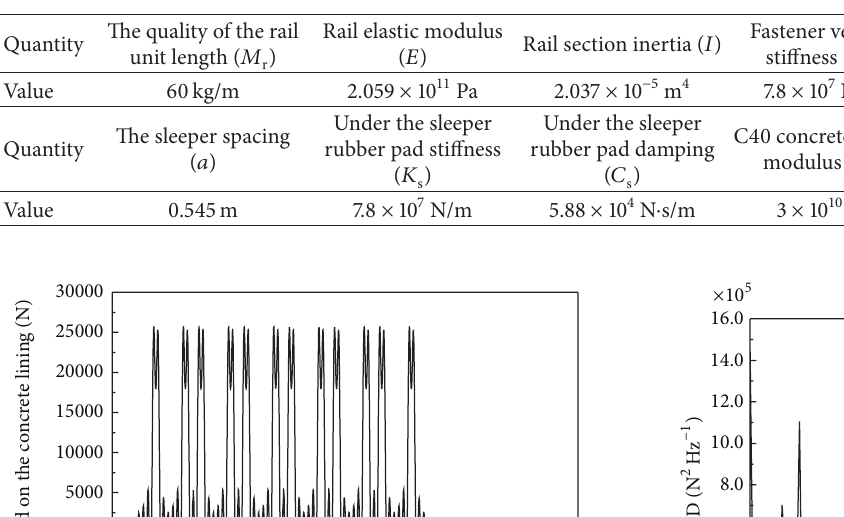
Table 2: Wheel coupling system orbit parameters.